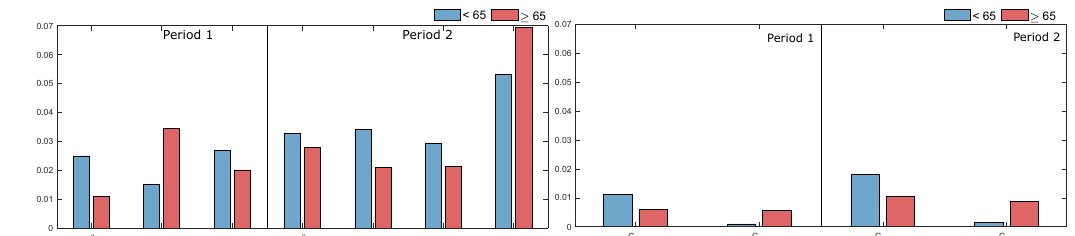
Figure 6. Sensitivity analysis for the 2-age group model was performed for the 2-window period: 2001 to 2011 and 2012 to 2018. In the left panel, transmission rates β 2 and the early diagnostic rate, α 2 in Group 2 ( ≥ 65 years) for the period from 2 2 2012 to 2018 year were most significant. The right panel showed the results of the contact rates, which were less